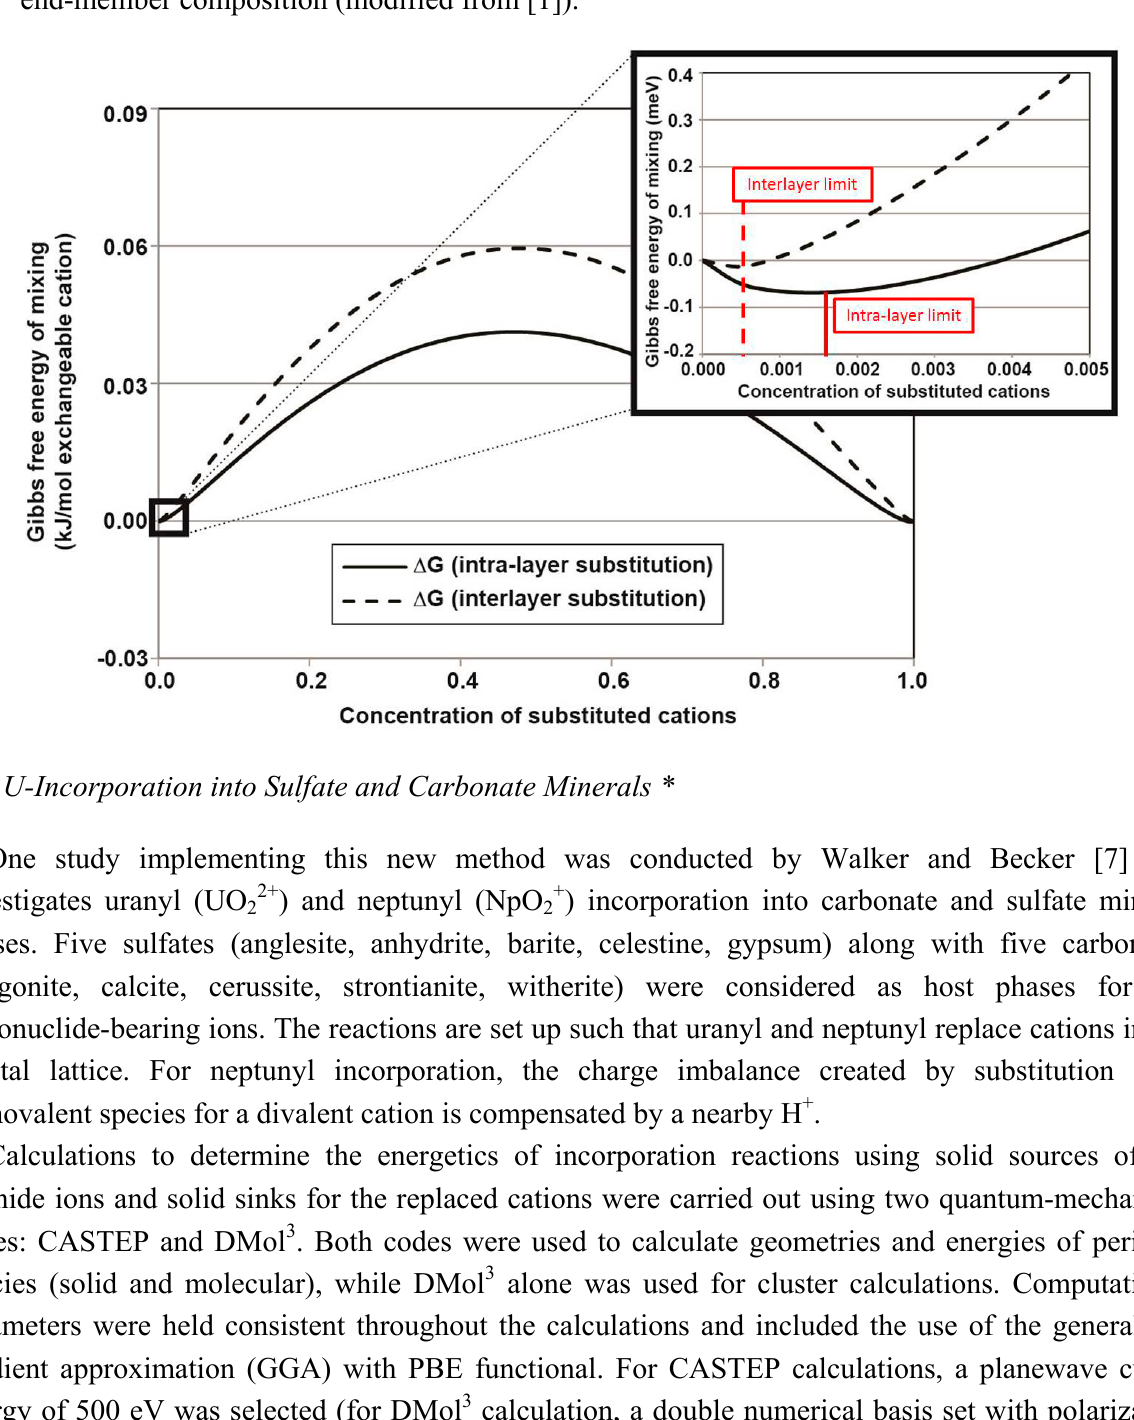
) vs. composition at 300 °C for the Np-U mix near the mix